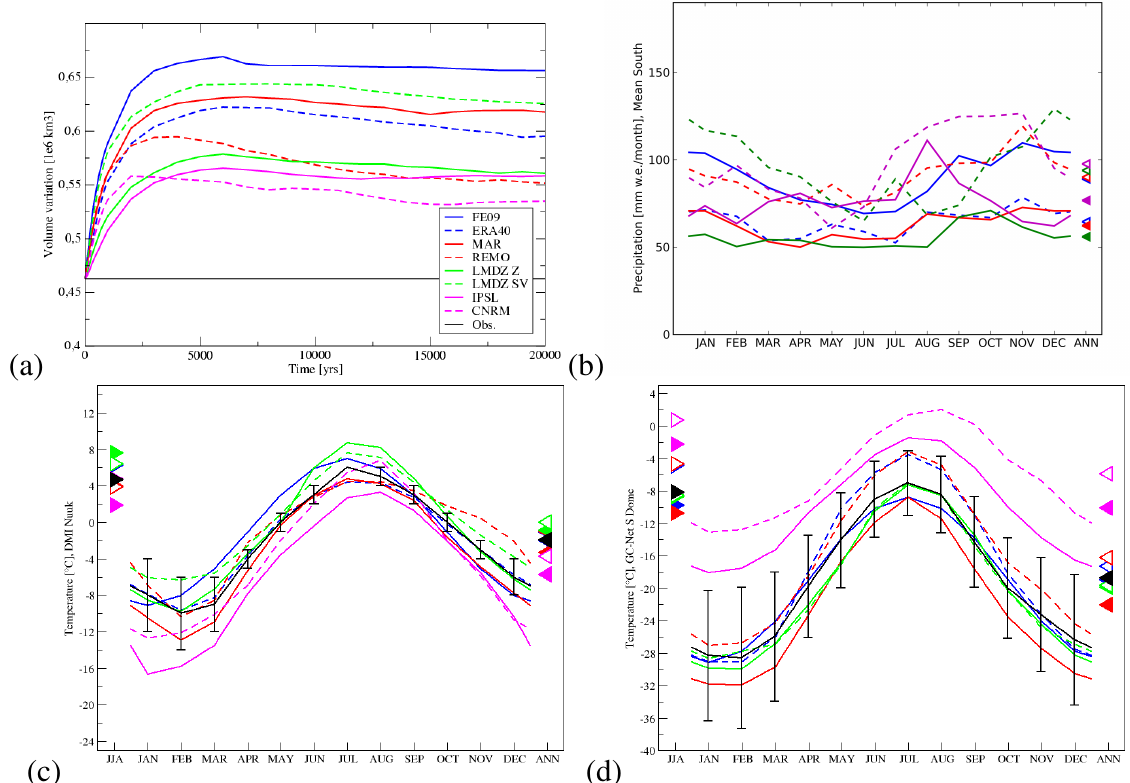
Fig. 7. (a) : South Greenland (latitudes lower than 68 ◦ N) simulated ice volume evolution for the steady state model runs shown in Fig. 5. The regional initial volume corresponds to the observed one. (b) : Regional (land mask with latitudes lower than 68 ◦ N) monthly mean precipitation for each individual atmospheric forcing, with annual mean values (triangles). (c, d) : Station climatology for, respectively, Nuuk (DMI) and South Dome (Steffen et al., 1996), and closest grid point near surface air temperature for each individual atmospheric forcing, with July temperature (left-sided triangles) and annual mean temperature (right-sided triangles). The black markers stand for the observations (initial regional ice volume and t2m stations measurement). Vertical bars are standard deviations from the monthly mean in the observations datasets. Time periods vary, depending on availability. 45